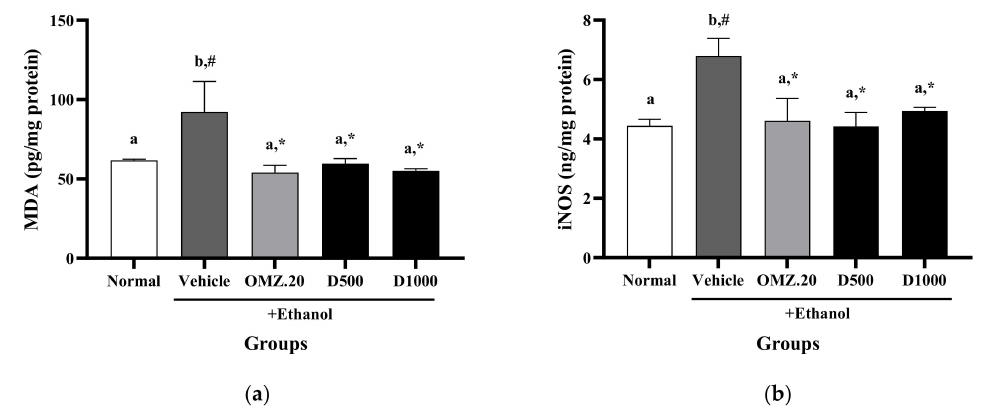
Figure 5. Effects of OMZ and Phy-Blica-D on the levels of MDA ( a ) and iNOS ( b ) in the stomachs of rats exposed to ethanol. Data are expressed as the mean ± SEM ( n = 6 per group) and were analyzed using one-way ANOVA and Duncan’s post hoc multiple-comparison test. * Significantly different from the vehicle control at p < 0.05. # Significantly different from the normal group at p < 0.05. Different letters ( a,b ) indicate significant differences ( p < 0.05) between treatments determined by Duncan’s multiple-range